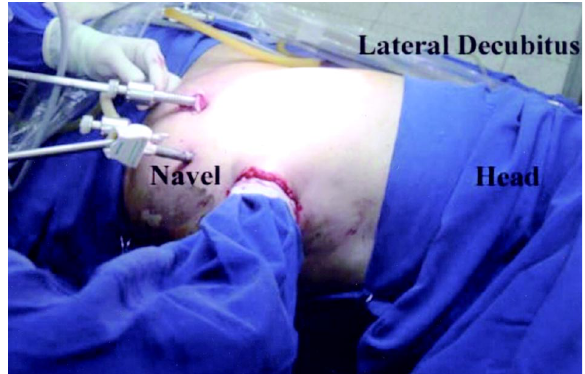
Figure 3 – Positioning, trocars and surgical team in hand-as- sisted technique for laparoscopic retroperitoneal lymphadenec- tomy.